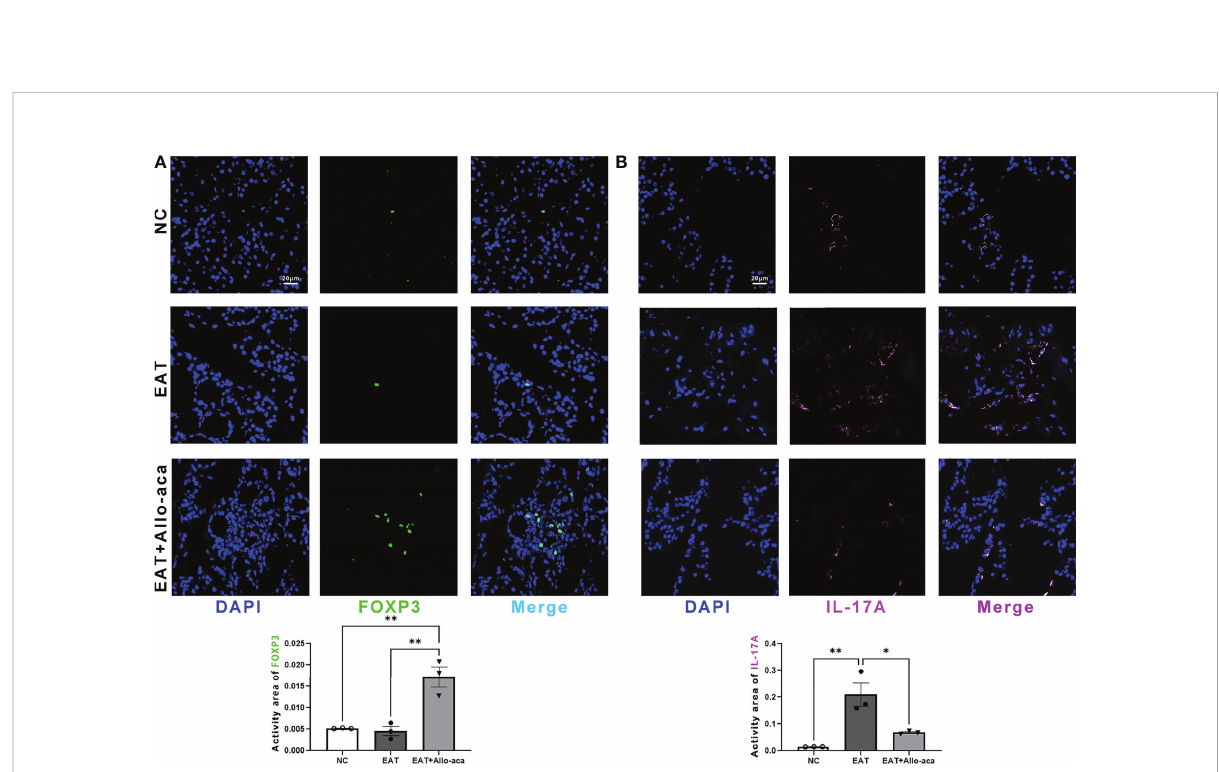
FIGURE 5 Allo-aca altered the expression of FOXP3 and IL -17A in the thyroid gland of EAT mice. (A) Allo-aca increased the level of FOXP3 in the thyroid gland of EAT mice. (B) The level of IL -17A was increased in the thyroid gland of EAT mice and was signi fi cantly attenuated by Allo-aca. FOX3P was labeled in green, IL -17A was labeled in pink, and nuclei were stained with DAPI. Scale bar: 20µm. n =3, data are expressed as mean ± standard deviation, * P < 0.05, ** P <